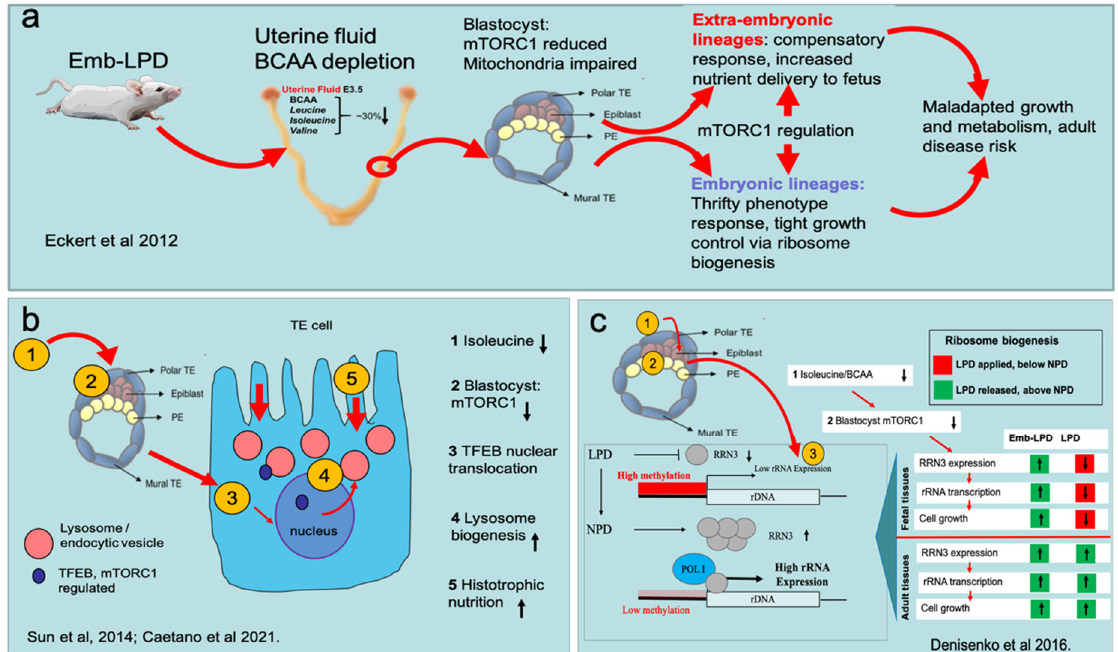
Figure 2. Diagrammatic representation of the stepwise nature of altered developmental programme mediated through maternal Emb-LPD. ( a ) Overview, from BCAA (branched-chain amino acid) depletion in uterine fluid, reducing mTORC1 signalling in the blastocyst, leading to distinct changes in extra-embryonic and embryonic tissues and later-life disease. ( b ) Activation of increased histotrophic nutrition in trophectoderm (TE) mediated through low BCAA availability and TFEB translocation. A similar mechanism occurs in the primitive endoderm (PE) derivatives. Orange numbers represent steps in induction of histotrophic nutrition listed on the right where black arrows indicate increased or decreased levels/activity. ( c ) Activation of altered ribosome biogenesis in somatic tissues (derived from Epiblast) mediated through dietary sensing, RRN3 expression and rRNA transcription. Orange numbers represent steps in induction listed on the centre/right and, for 3, the effect of diet on ribosome biogenesis (bottom left) and life stage (bottom right). Key references for these outcomes are identified; in sequence being ( a ) 46; ( b ) 63 and 65; ( c ) 94. See text for details.